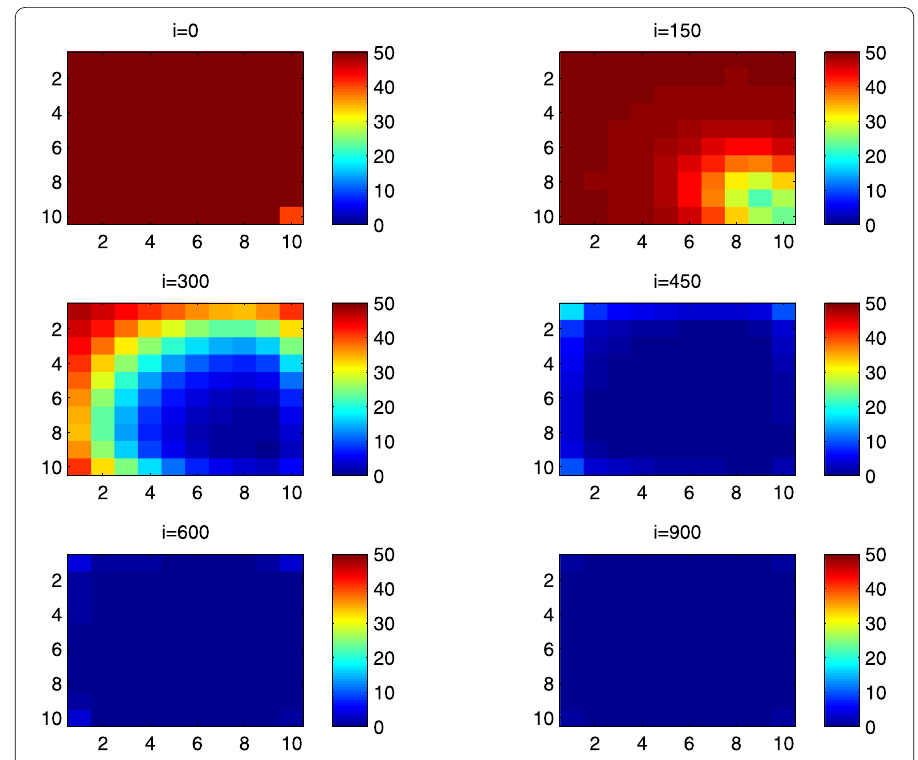
Figure 2 S Cpq behavior in the absence of control. The case when the disease starts from the corner C 11 .